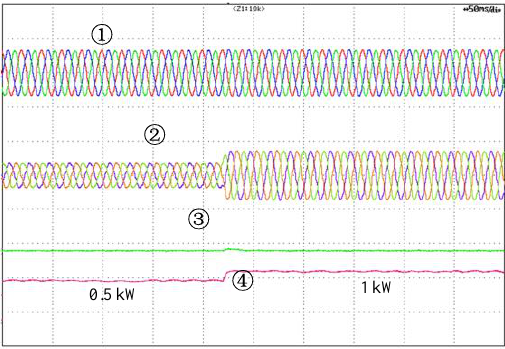
Figure 17. HFR damping for the VSC system.